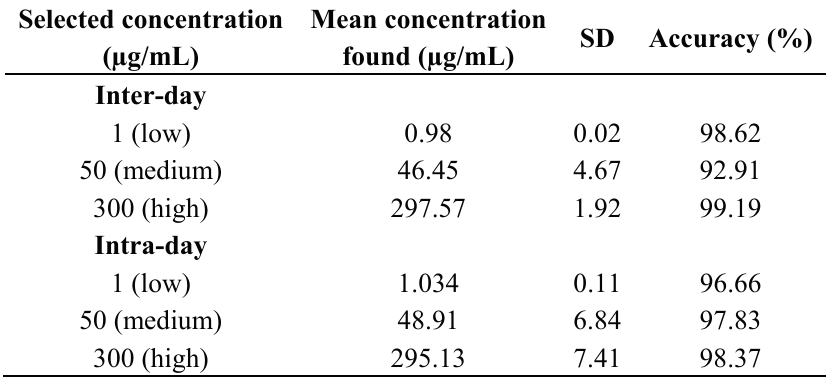
Table 2 . Accuracy and precision of the HPLC method ( n =